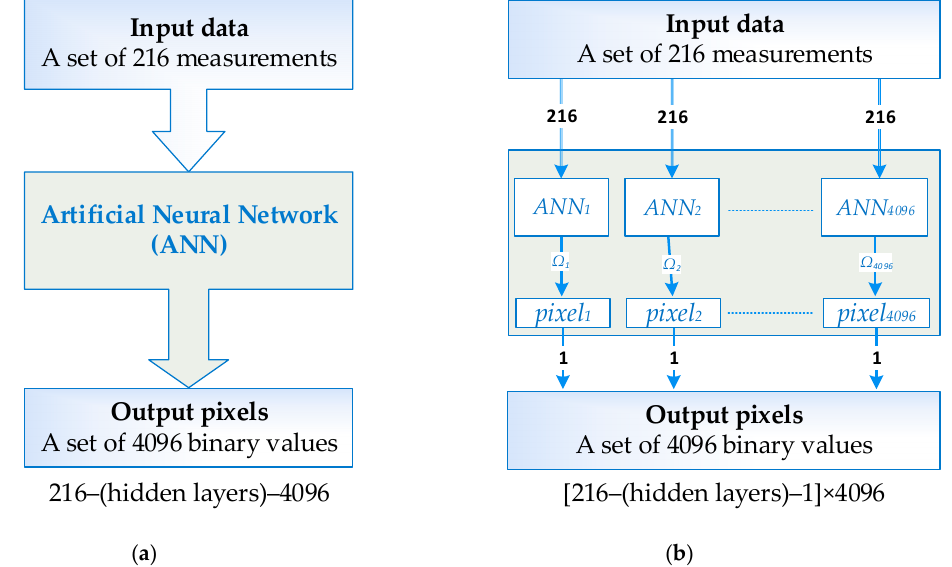
Figure 1. Comparison of algorithms for methods: ( a ) artificial neural network (ANN) and ( b ) multiple artificial neural network (MANN).